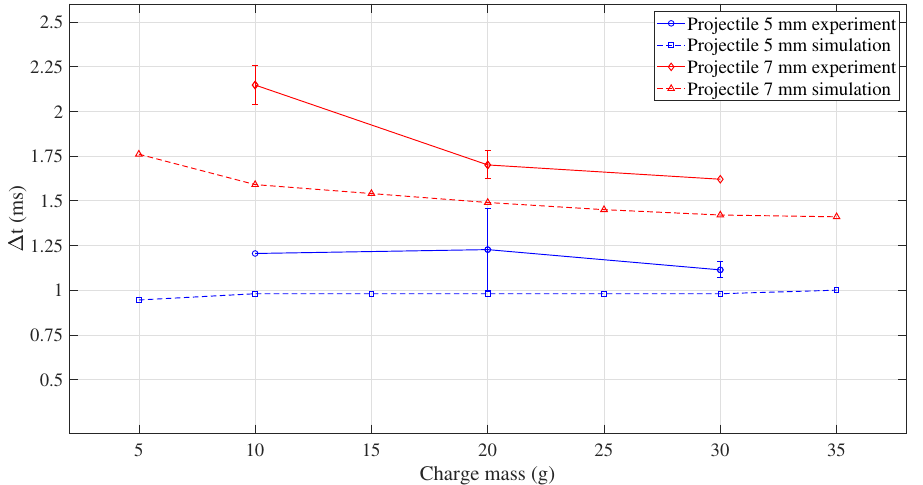
Figure 20. Comparison between experimental and numerical simulation results of the time interval ∆ t (shown by mean and standard deviation for experiments) at the tube’s exit (1200 mm) for the different explosive charges and projectile